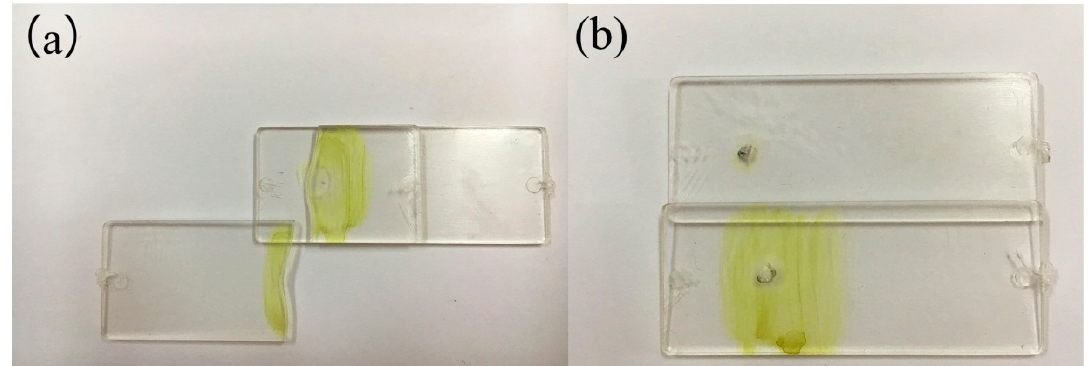
Figure 4. The fracture modes of 480 V, 6 mm. ( a ) type I; ( b ) type II.